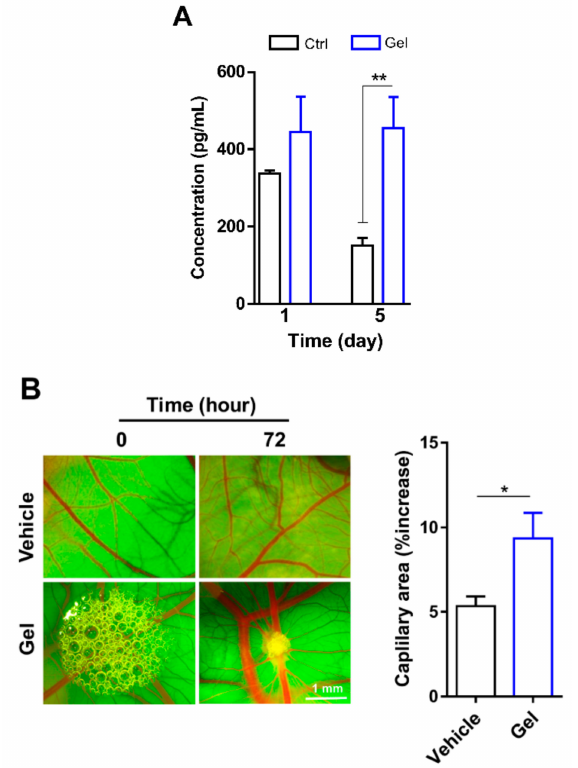
Figure 2. Angiogenic potential of (RADA) 4 -SDKP hydrogel. ( A ) Vascular endothelial growth factor (VEGF) release by human umbilical vein endothelial cells (HUVECs) cultured on either tissue culture plate as the control (Ctrl) or encapsulated in 0.25% (RADA) 4 -SDKP (Gel) after 1 and 5 days. ( B ) Representative images of the 0.25% (RADA) 4 -SDKP hydrogel placed on the chorioallantoic membranes (CAMs) at 0 and 72 h of incubation ( n = 5, p ≤ 0.05). Quantification of blood vessel area demonstrated that the 0.25% (RADA) 4 -SDKP hydrogel resulted in a statistically significant increase in response. Data are shown as mean ± standard deviation ( n = 3). * p < 0.05, ** p <